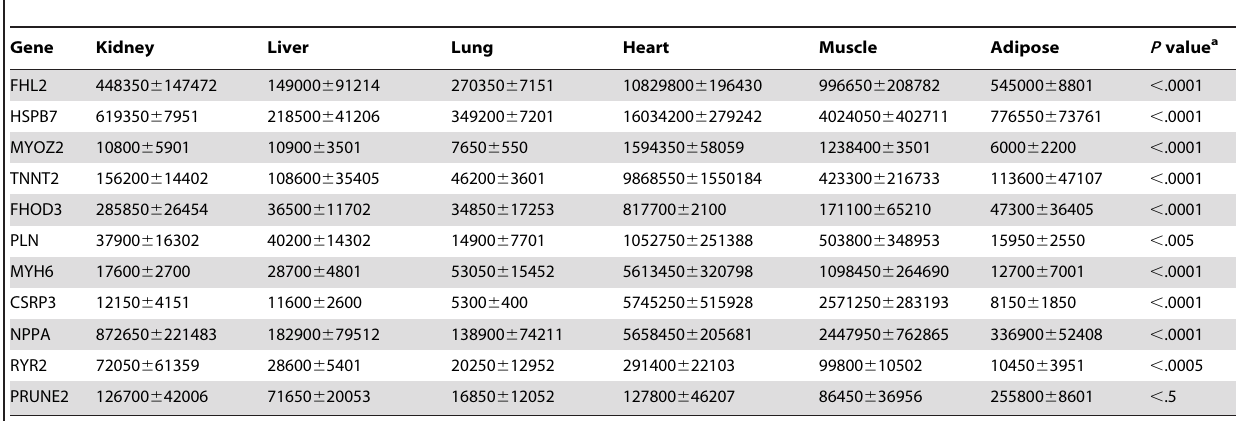
Table 8. Human heart-specific gene expression